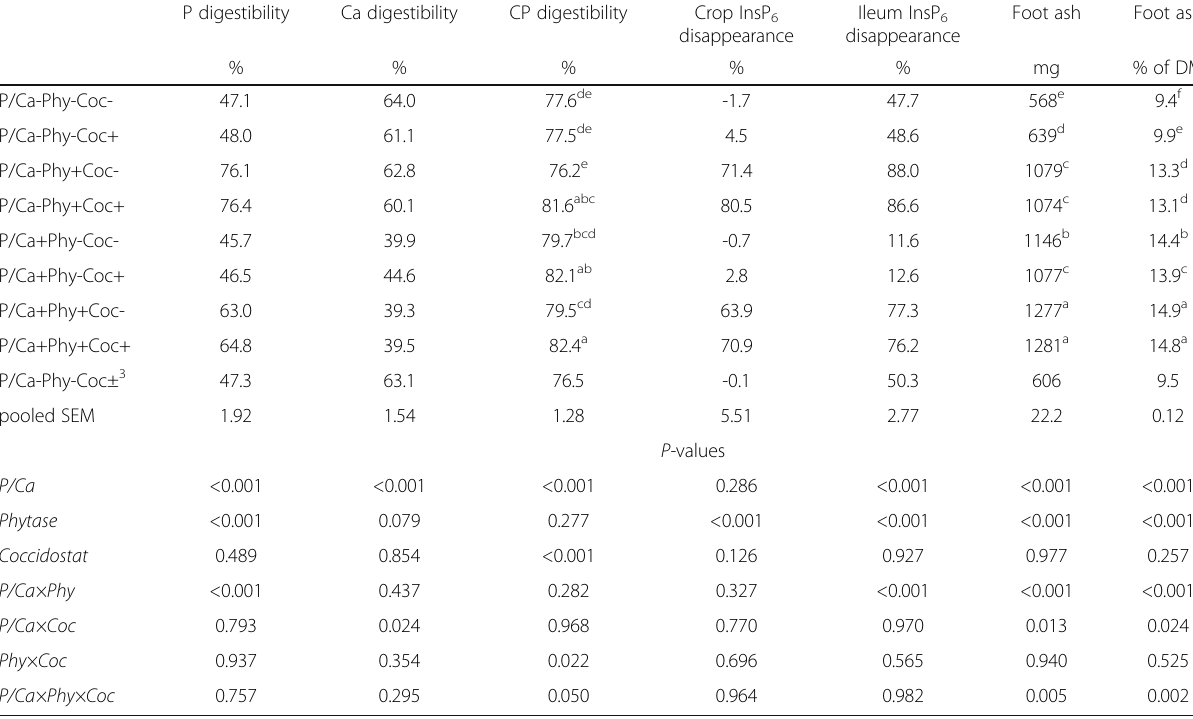
Table 2 Effect of the experimental diets on precaecal nutrient digestibility, InsP 6 disappearance 1 , and foot ash